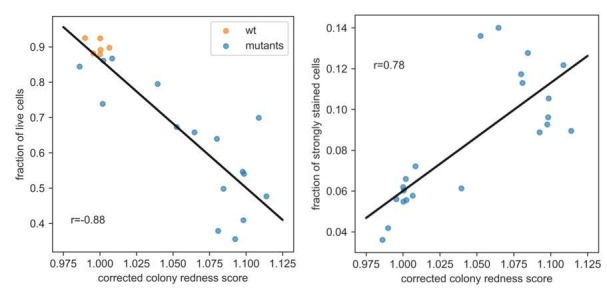
The fraction of live cells (neither burst nor strongly stained in flow cytometer, left panel) better explains the colony redness score than the fraction of strongly stained cells only (right panel).This suggests that burst cells do contribute to staining in the colony (while being unstained in the flow cytometer). Note that the correlation breaks down for colonies with higher redness scores (which have more burst cells).